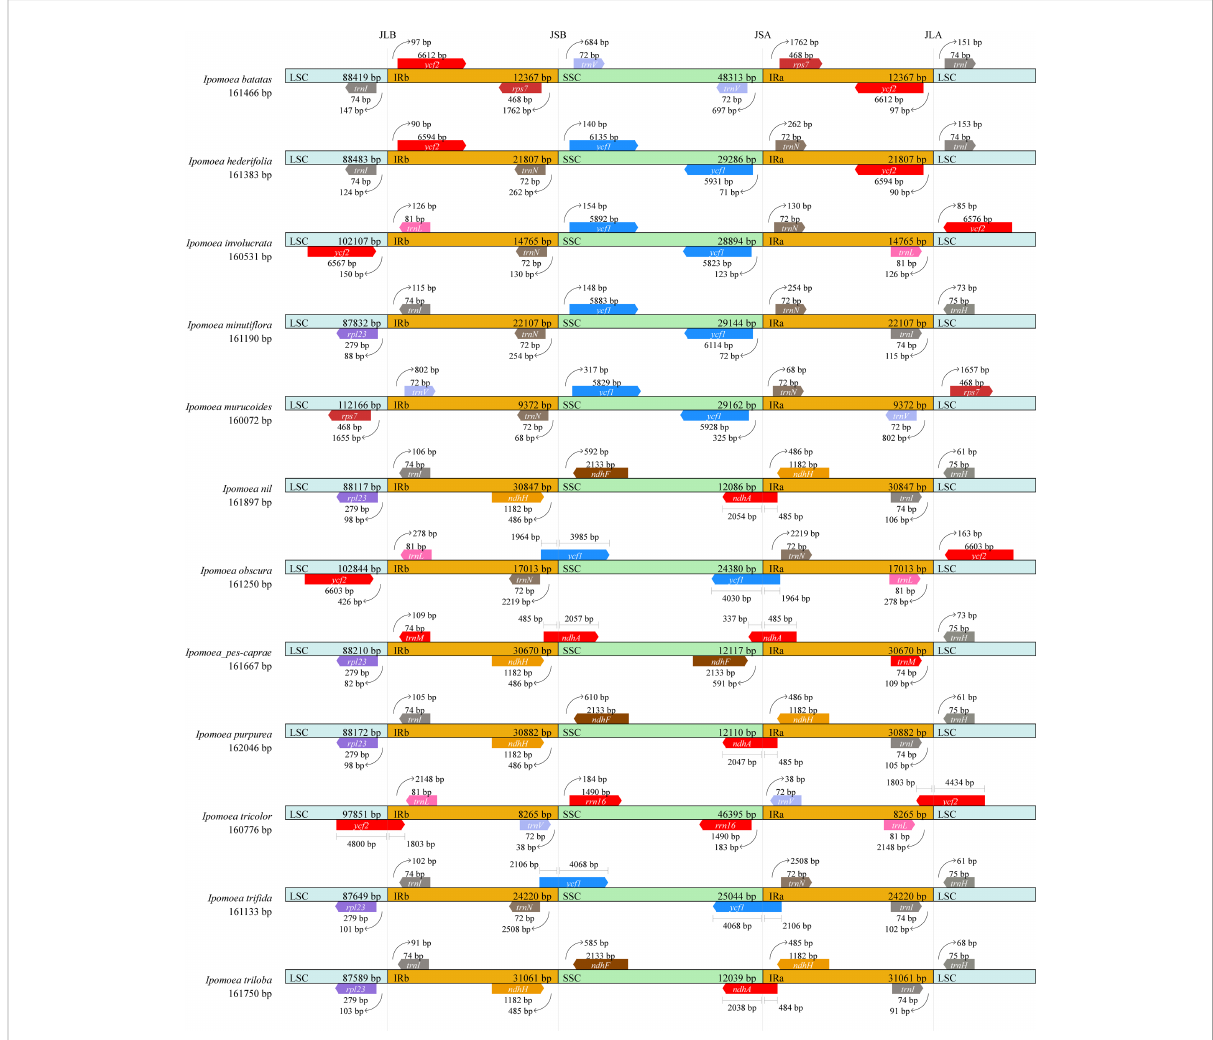
FIGURE 4 Comparison of the borders of the IR, SSC, and LSC regions among 12 chloroplast genomes of Ipomoea species . JLB, JSB, JSA, and JLA represent the junctions of LSC/IRb, IRb/SSC, SSC/IRa, and IRa/LSC,